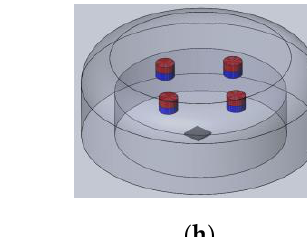
Figure 1. Several structures of soft fingertips consisting of one 3-axis Hall sensor and magnet(s):